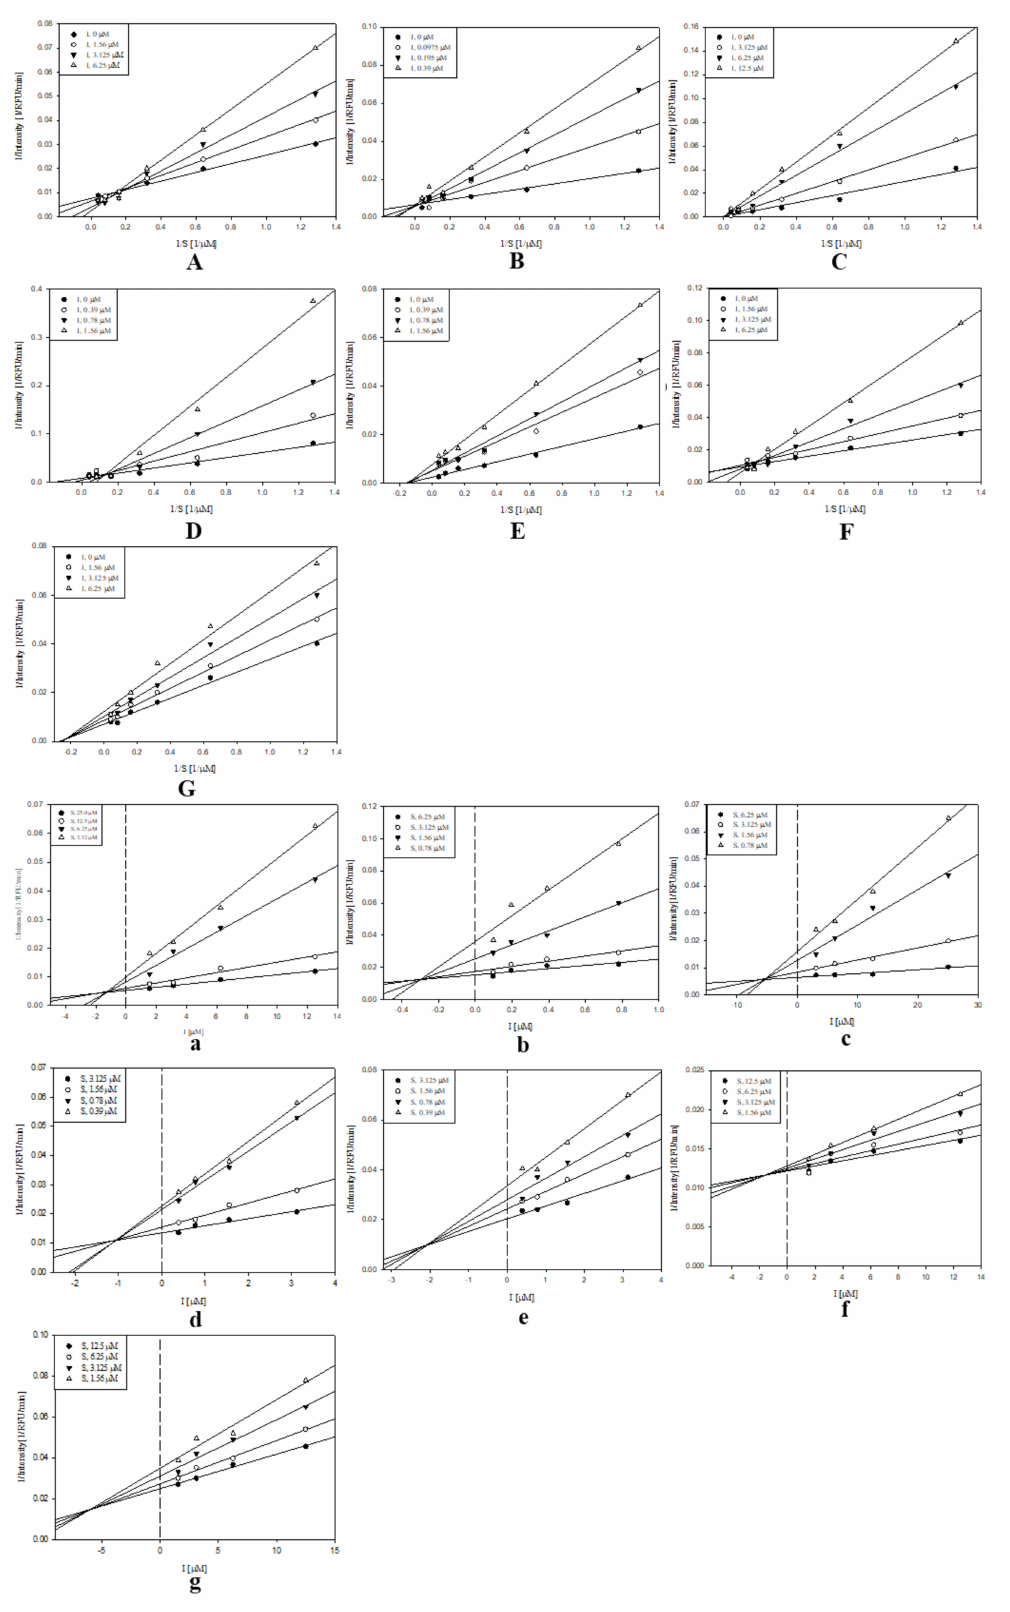
Figure 2. Study of the binding mechanisms between compounds 1 – 7 and sEH: ( A – G ) Lineweaver − Burk plots for compounds 1 – 7 , respectively; ( a – g ) Dixon plots for compounds 1 – 7 , respectively. Data are the mean of three experiments carried out in triplicate and were determined by one-way analysis of variance, followed by Dunnett’s multiple comparison test, p < 0.05 versus